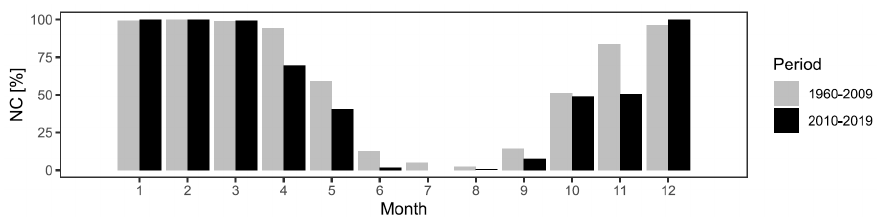
Figure 9. Time series of: ( a ) mean temperature of accumulation and ablation seasons extrapolated at the glacier’s mean elevation; ( b ) seasonal nivometric coefficient (NC) at the glacier’s mean elevation; total precipitation amount of ( c ) accumulation season, and ( d ) ablation season, fractioned into solid and liquid portions at the glacier’s mean elevation.